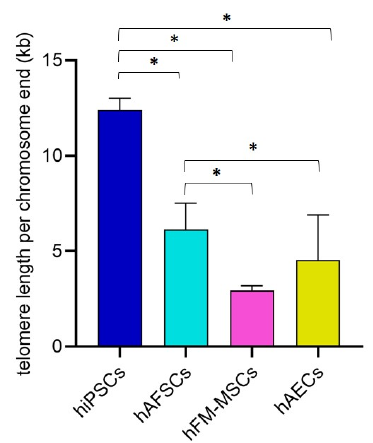
Figure 6. The telomere length per each chromosome end (in kb) in hiPSCs and perinatal SCs was quantified by qPCR. All the cells were at 2–4 passages. The graphs show the mean ± SD of 5 independent experiments, * p <